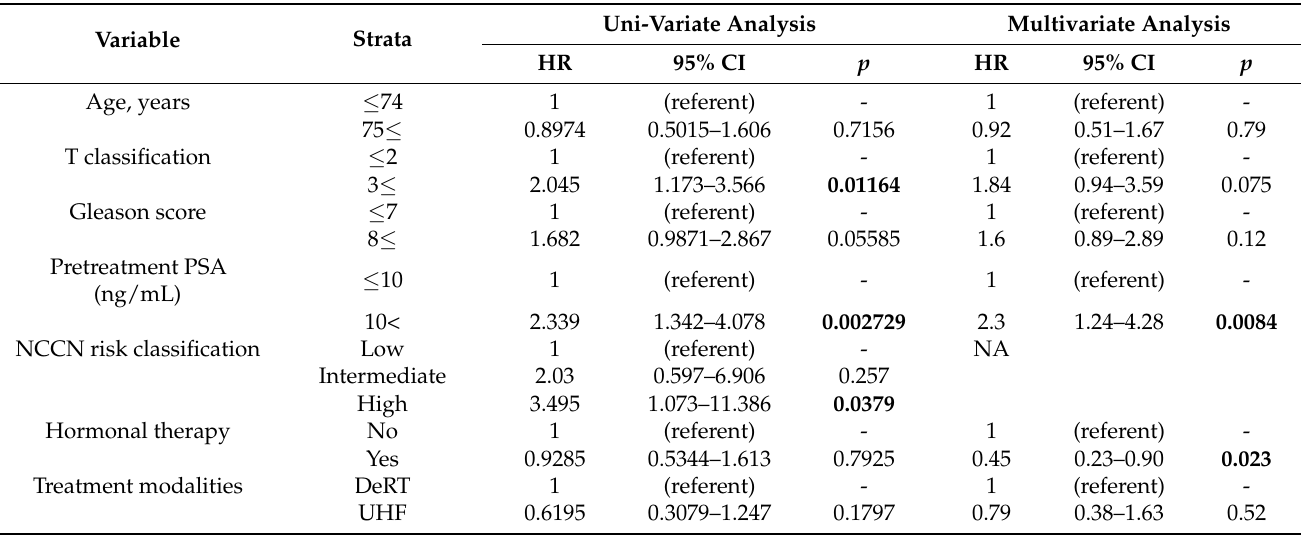
Bold values indicate statistically significance.